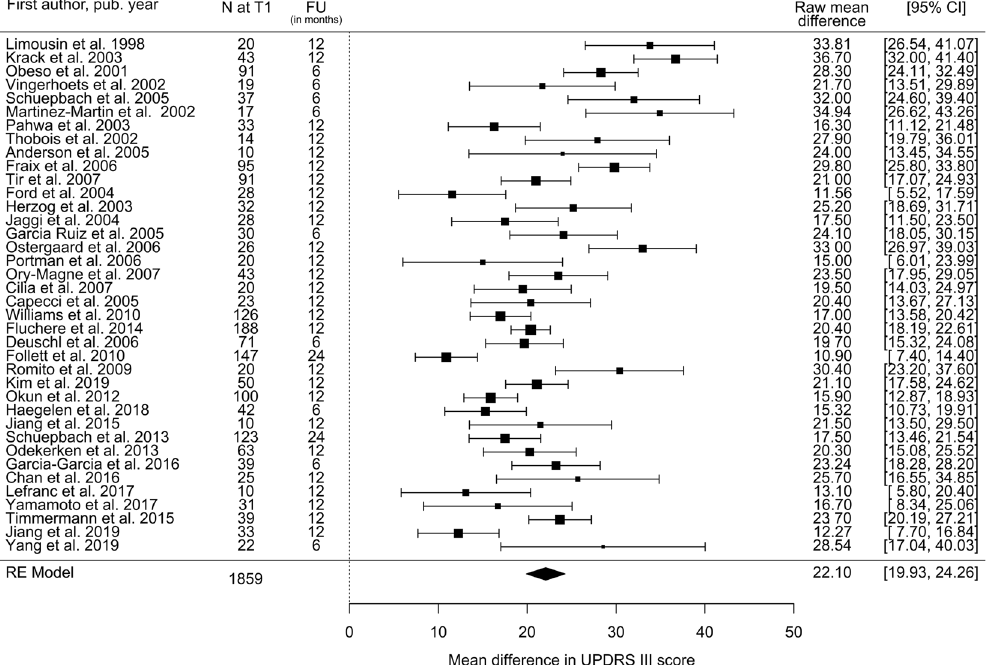
Fig. 3 Estimated decrease in total UPDRS-III score following STN-DBS. Postoperative stimulation-ON/medication-OFF vs. preoperative OFF- medication state: UPDRS III Mean Difference. N = number of subjects at follow-up; FU = follow-up time; CI = con fi dence interval; RE Model = random-effects model.